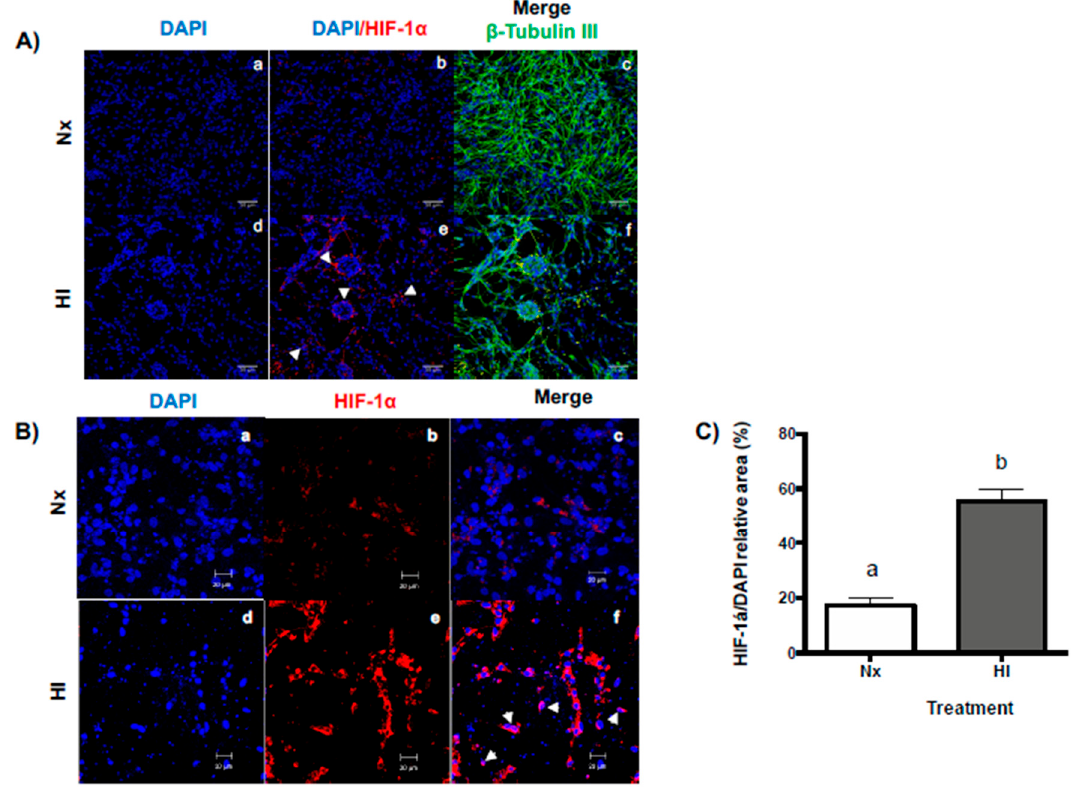
Figure 2. Expression of hypoxia-inducible factor-1 alpha (HIF-1 α ) and cell organization in primary cerebellar cultures exposed to either normoxic (Nx, 95% air-5%CO 2 , 4.5 g/L glucose) or hypoxic-ischemic (HI, <5% O 2 , 1 g/L glucose) incubation conditions for 12 h. ( A ) Representative ICC confocal images show the expression of HIF-1 α (red), the neuronal marker ß-Tubulin III (green), and cell nuclei counterstained with DAPI (blue), under Nx ( Aa – Ac ) and HI ( Ad – Af ) conditions. HIF-1 α immunoreactivity was enhanced after HI exposure (white arrows, Ae ) in comparison to Nx ( Ab ). In addition, in contrast to regular cell distribution in the Nx controls, an important proportion of cell clumping and reorganization of ß-Tubulin III was observed in HI-injured cultures. Scale bars = 50 µ m. ( B ) Representative ICC confocal images show the effect of HI upon the cell nuclei number (DAPI, blue) and HIF-1 α (red) expression under Nx ( Ba – Bc ) and HI ( Bd – Bf ) incubation conditions. Merged images show that hypoxia-ischemia injury provoked an important reduction in cell number as well as a significant enhancement of HIF-1 α immunoreactivity, mainly in the perinuclear areas (white arrows, Bf ) in comparison to the Nx controls ( 2Bc ). Scale bars = 20 µm. ( C ) Quantification of data in ( B ) is presented as the percentage (%) of the ratio between HIF-1 α and DAPI fluorescence. Each bar represents the mean ± SEM, n = 4 independent experiments performed in duplicate. Different letters indicate significant difference ( p < 0.0001) as determined by an unpaired Student’s t test.